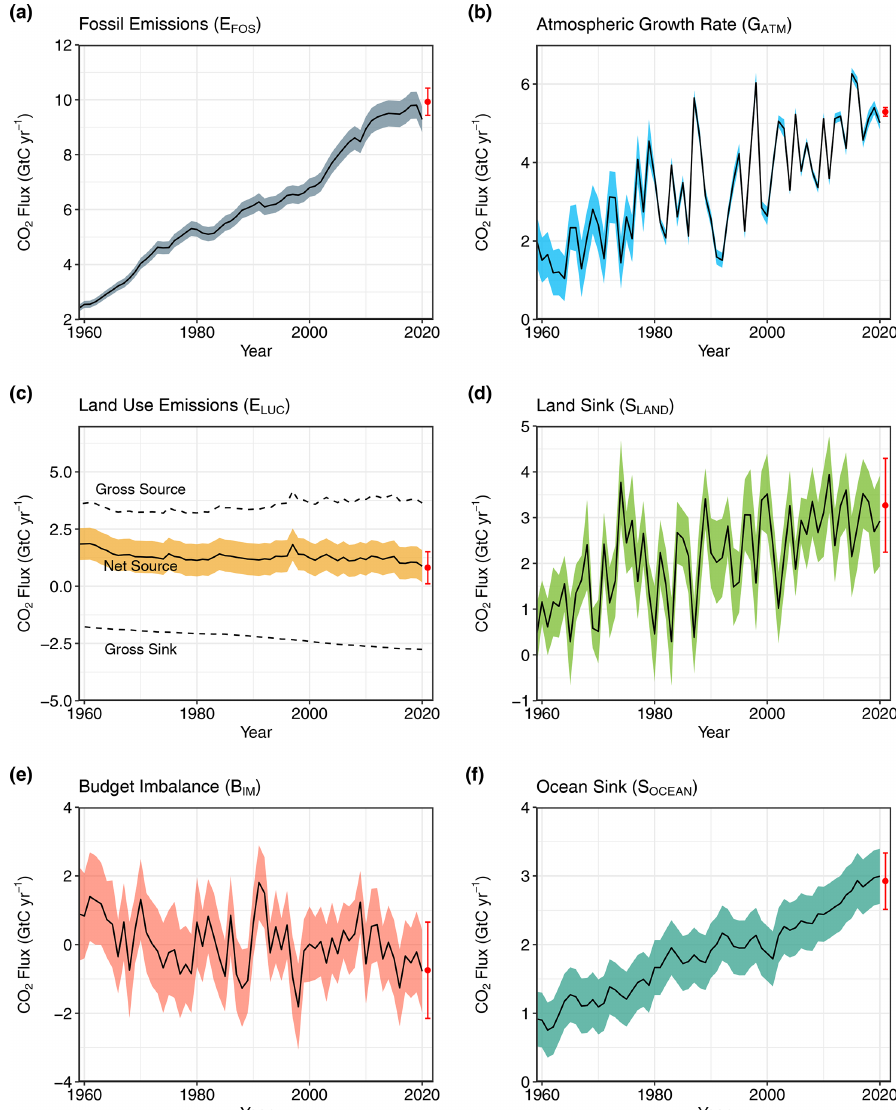
Figure 4. Components of the global carbon budget and their uncertainties as a function of time, presented individually for (a) fossil CO 2 emissions ( E FOS ), (b) growth rate in atmospheric CO 2 concentration ( G ATM ), (c) emissions from land-use change ( E LUC ), (d) the land CO 2 sink ( S LAND ), (e) the ocean CO 2 sink ( S OCEAN ), and (f) the budget imbalance that is not accounted for by the other terms. Positive values of S LAND and S OCEAN represent a flux from the atmosphere to land or the ocean. All data are in GtCyr − 1 with the uncertainty bounds representing ± 1 standard deviation in shaded colour. Data sources are as in Fig. 3. The red dots indicate our projections for the year 2021 and the red error bars the uncertainty in the projections (see